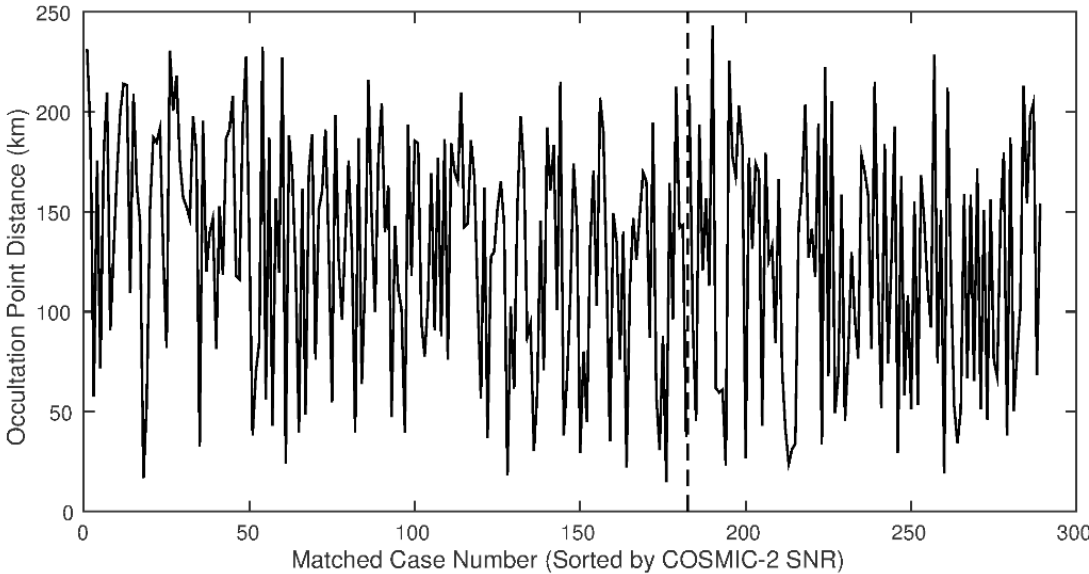
Figure 9. Occultation point distance for the SRO pairs between COSMIC-2 and GeoOptics. The vertical dashed line separates the GPS from the GLONASS.